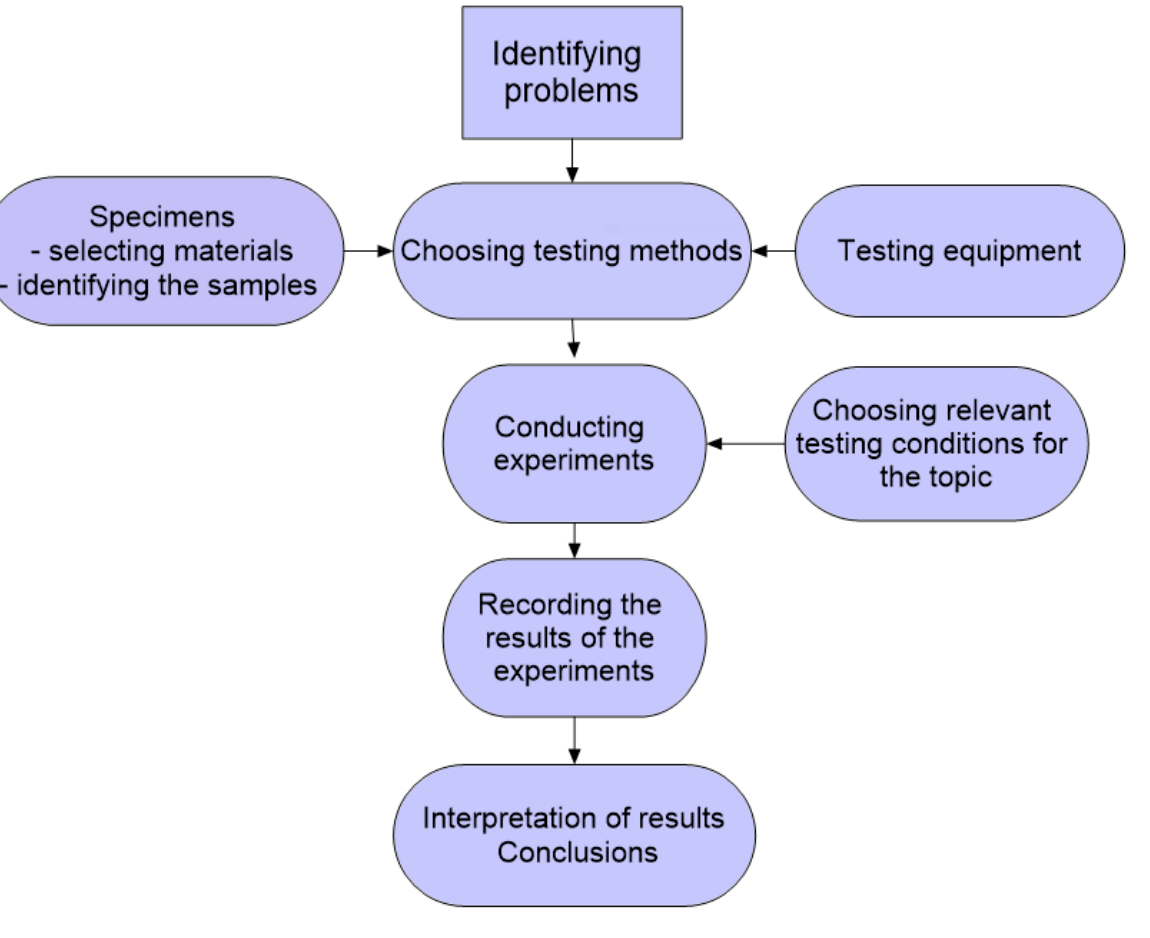
Figure 1. Research program map.